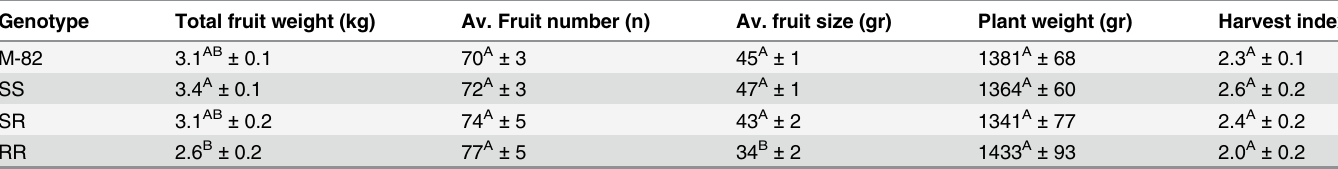
RR = plants homozygous for Pelo originating from TY172; SS = plants homozygous for Pelo originating from M-82; SR = heterozygous plants; different superscript letters indicate statistically signi fi cant differences, P < 0.05, between genotypes for each trait separately; ±